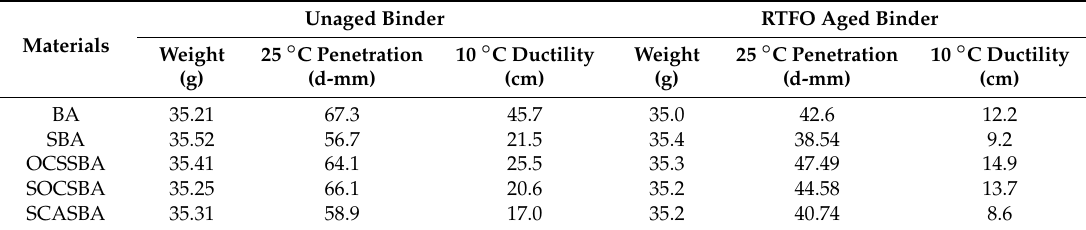
Table 6. Physical parameter of BA, SBA, OCSSBA, SOCSBA, and SCASBA before and after rolling thin film oven (RTFO) test.